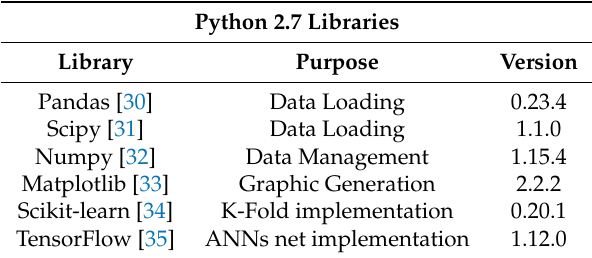
Table 3. Python 2.7’s libraries used in this work.